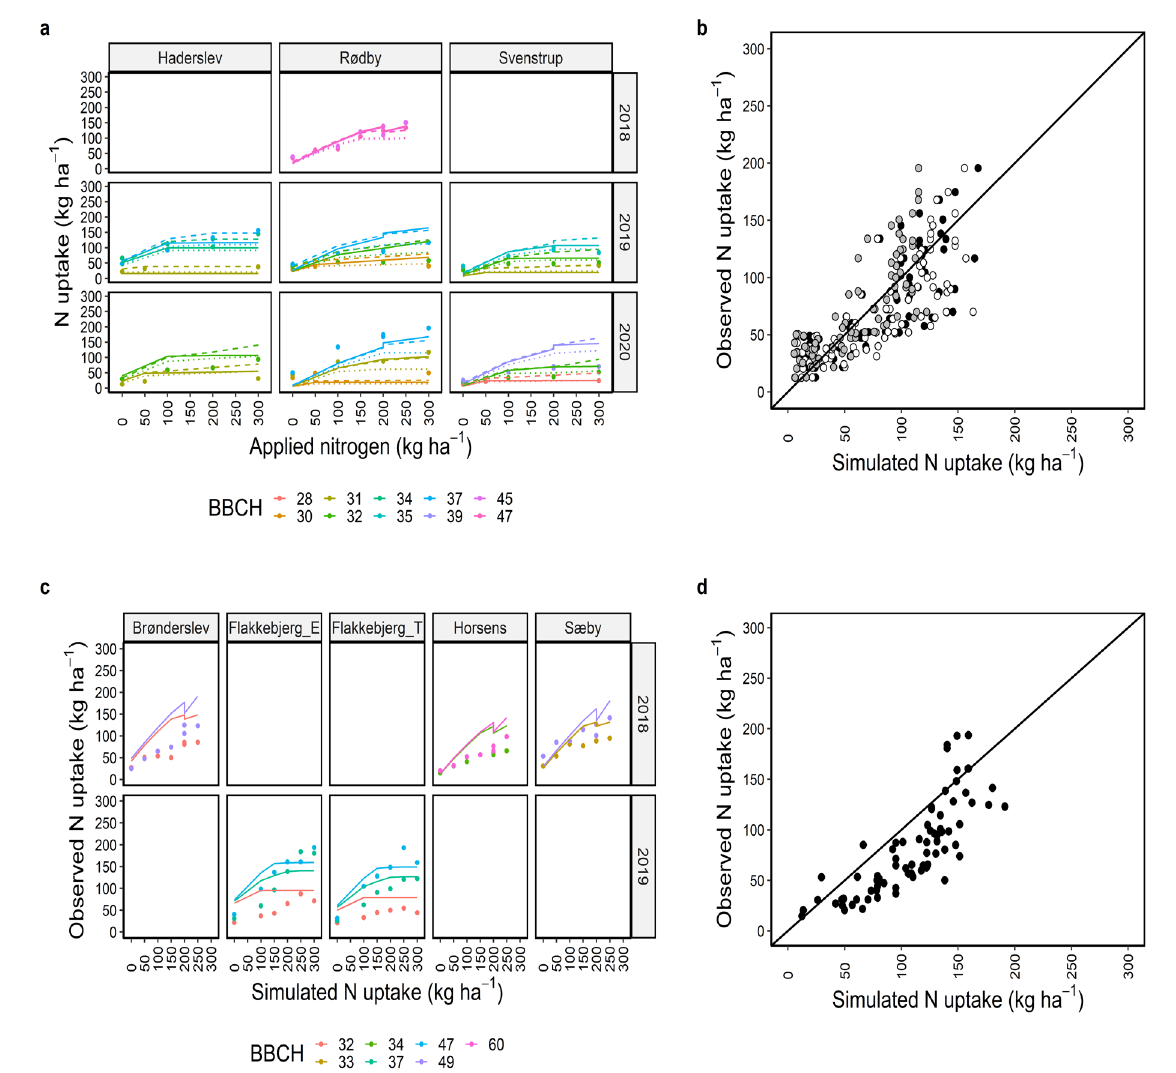
Figure 3. Calibration ( a , b ) and evaluation ( c , d ) of APSIM winter wheat model for N uptake under 7–13 nitrogen management scenarios. Coloured circles are observed data points and solid, dashed, dotted lines are model outputs with the current set of calibrated parameters for Dan_winter, default, and modified cultivars ( a , c ). Black, white, and grey circles represent model outputs using Dan_winter, default, and modified cultivars, respectively ( b , d ). Diagonal black lines in b and d are 1:1 lines. Discontinuous lines at 200 kg N application indicate the simulations output with single dose or split applications of N at the locations in the same year (Table S1). For Rødby in 2018, discontinuous line also indicated two simulations with different sowing dates.